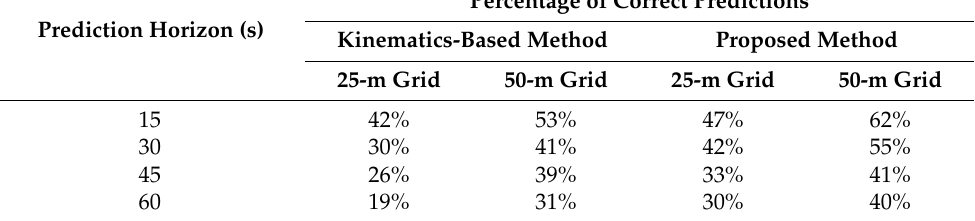
Table 1. Results of the proposed method and kinematics-based method for the grid zoning described in Figure 7a.